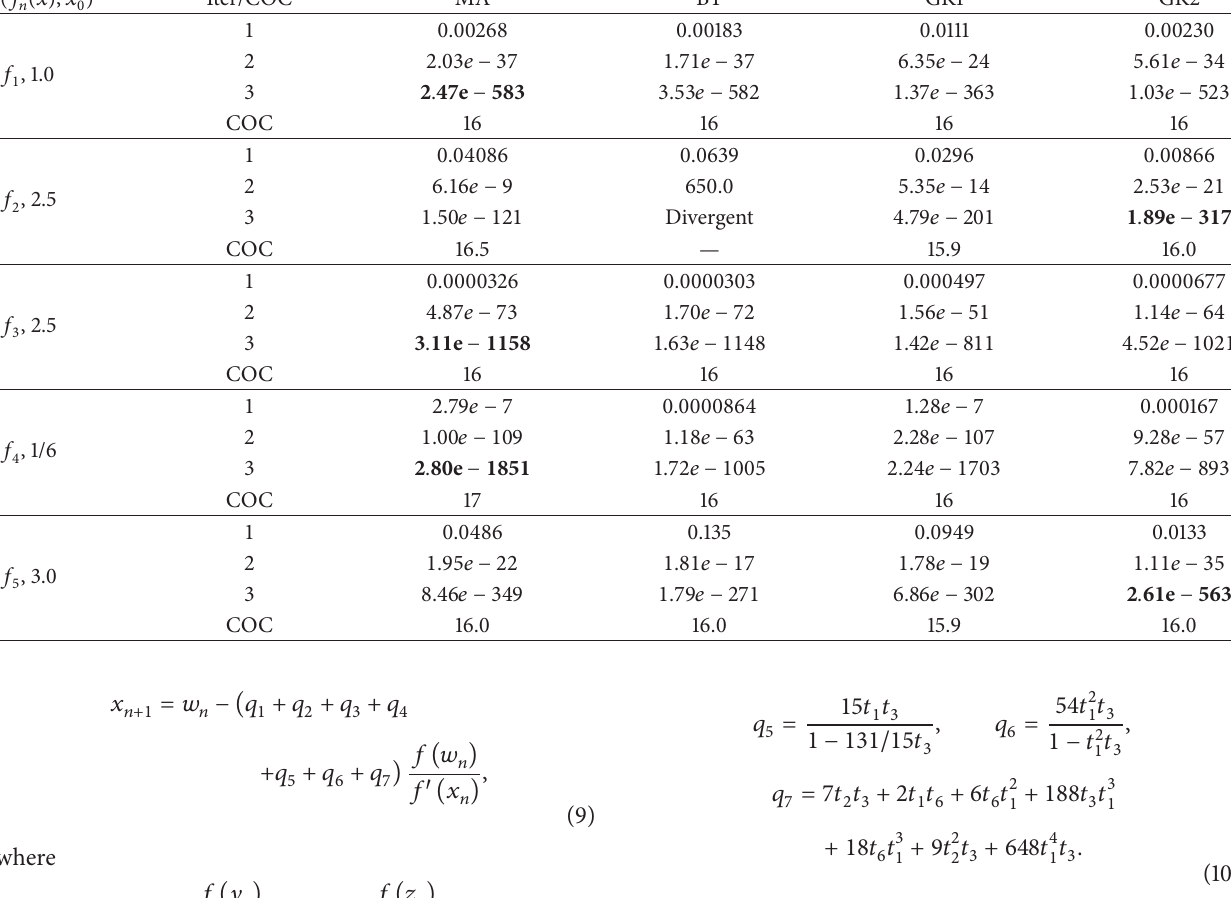
Table 2: Numerical comparison of absolute error |𝑥 𝑛 − 𝛼| , number of iterations =